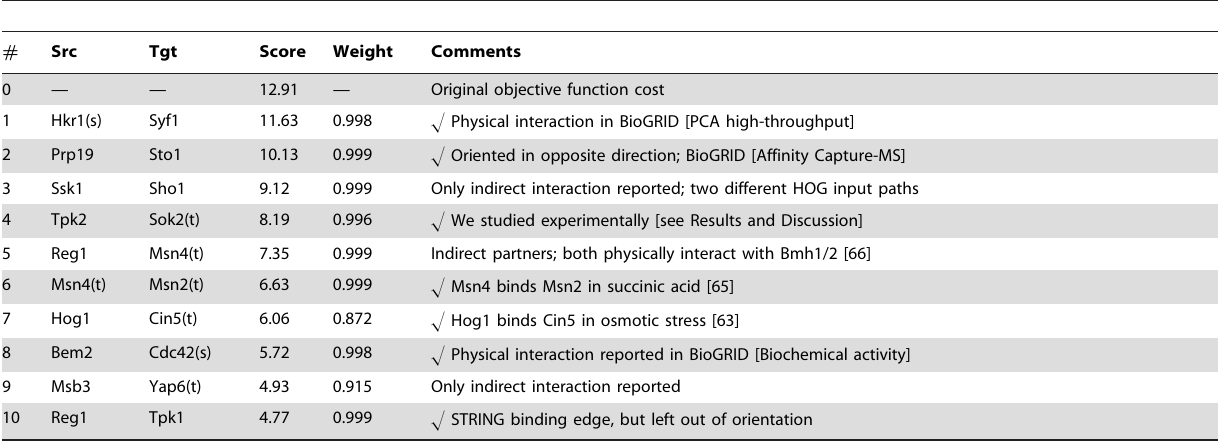
Table 2. Top 10 predictions for Shortcuts using the Greedy